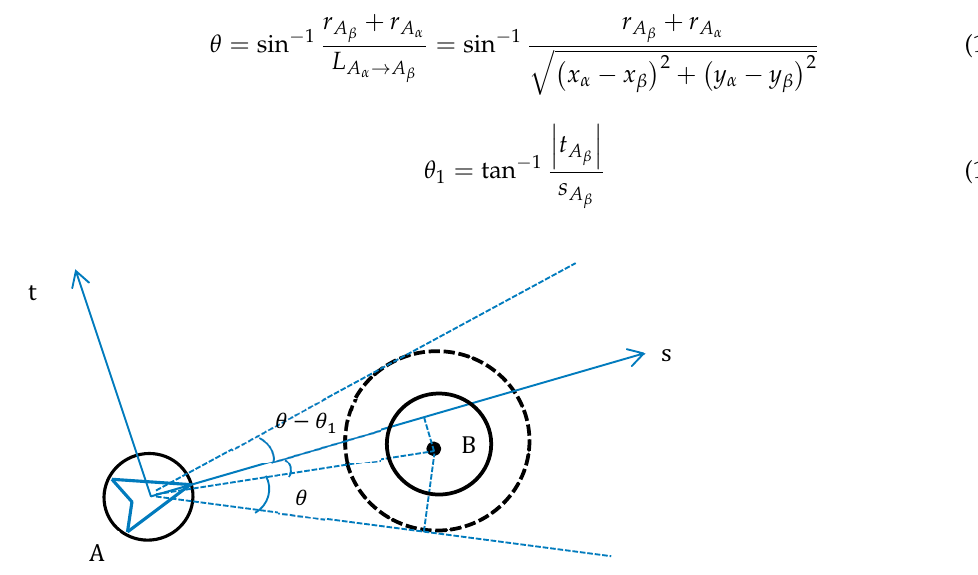
Figure 9. Sketch of collision detection.